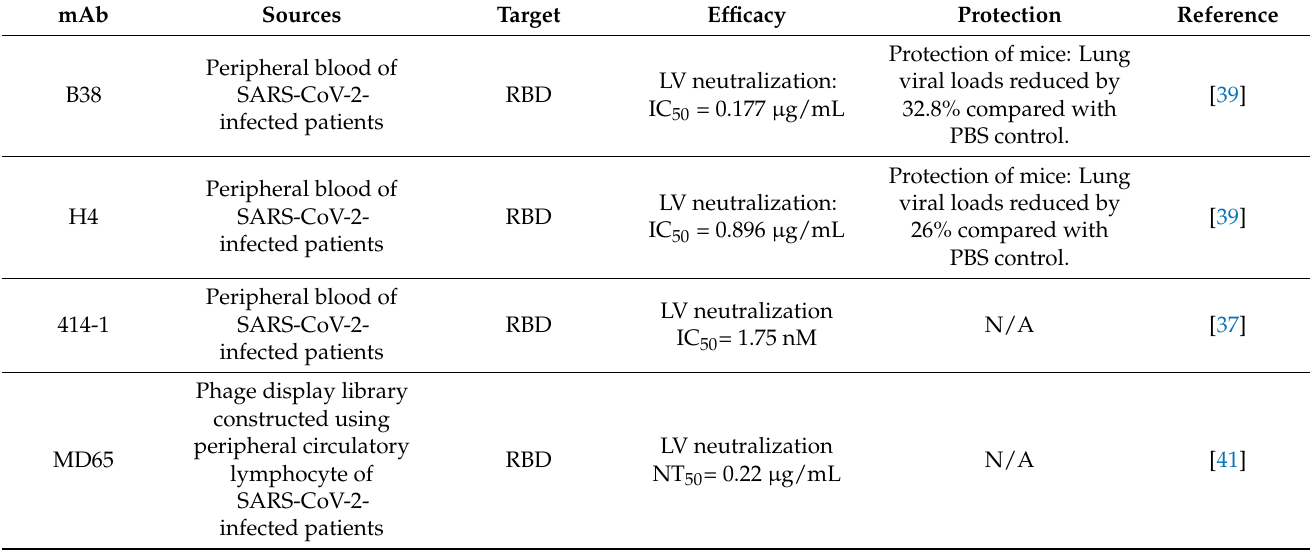
Table 1. Efficacies of the monoclonal antibodies recognizing the RBD of the S